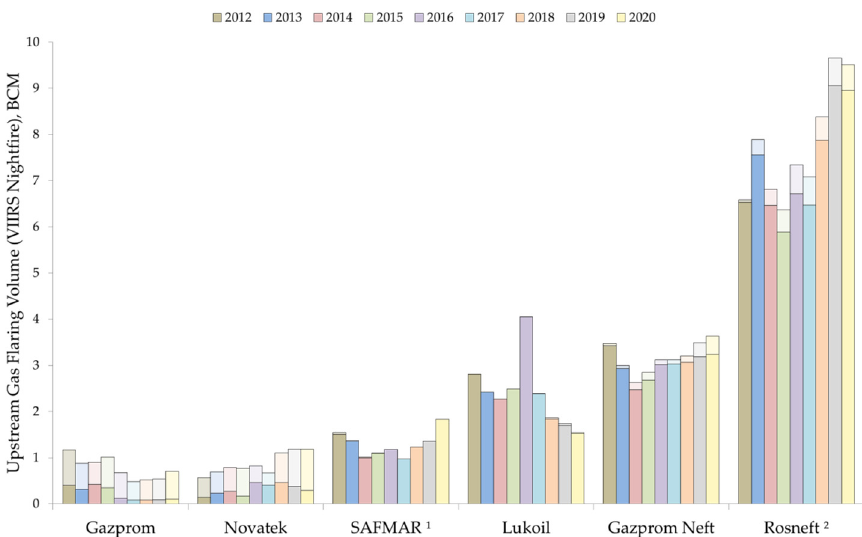
Figure 6. Upstream gas flaring volumes (in BCM) per major oil and gas companies (including their share in joint ventures) with the highest flaring rates in Russia. Solid and shaded areas represent flaring at oil and natural gas/gas condensate upstream facilities, respectively. 1 SAFMAR is a financial group controlling several oil companies (major RussNeft) founded in 2015. On the diagram, all later associated assets are retrospectively accounted for as a single entity in 2012–2014. 2 Rosneft acquired major oil companies TNK-BP in 2013 and Bashneft in 2016. Here, their flaring volumes are accounted for starting from the year of acquisition (2013 and 2016, respectively).